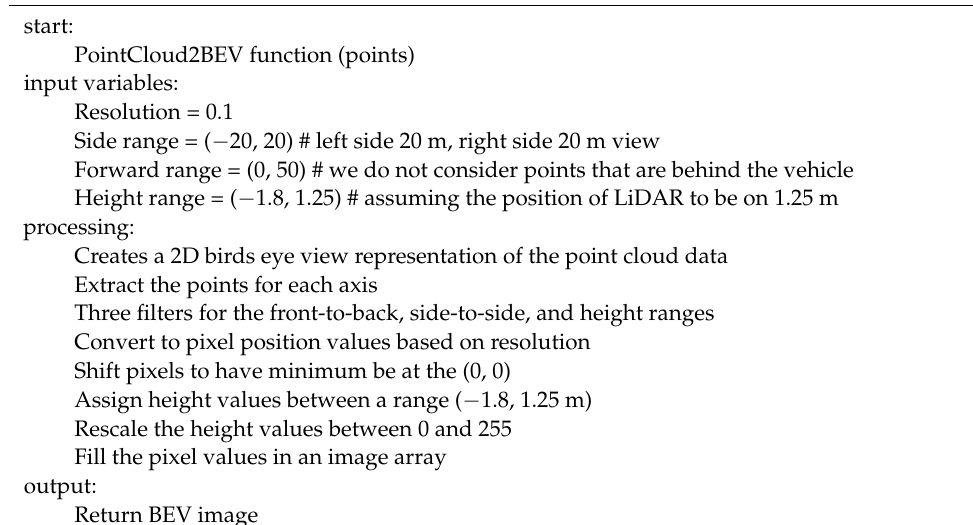
Algorithm 1. Pseudo-code for LiDAR to BEV